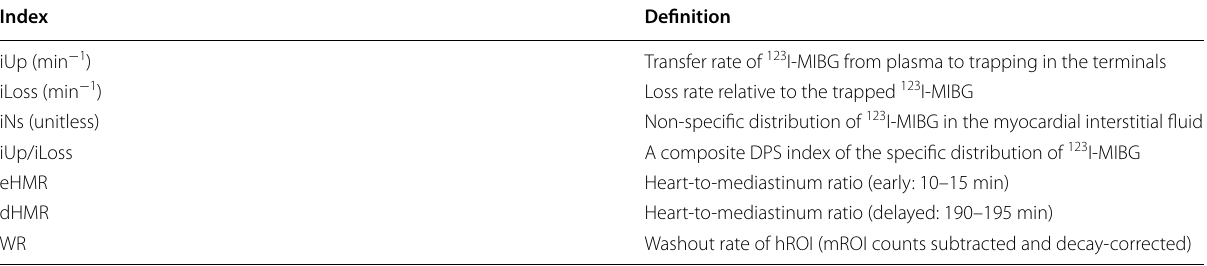
Table 1 Nomenclature of the kinetic indices for myocardial 123 I‑MIBG